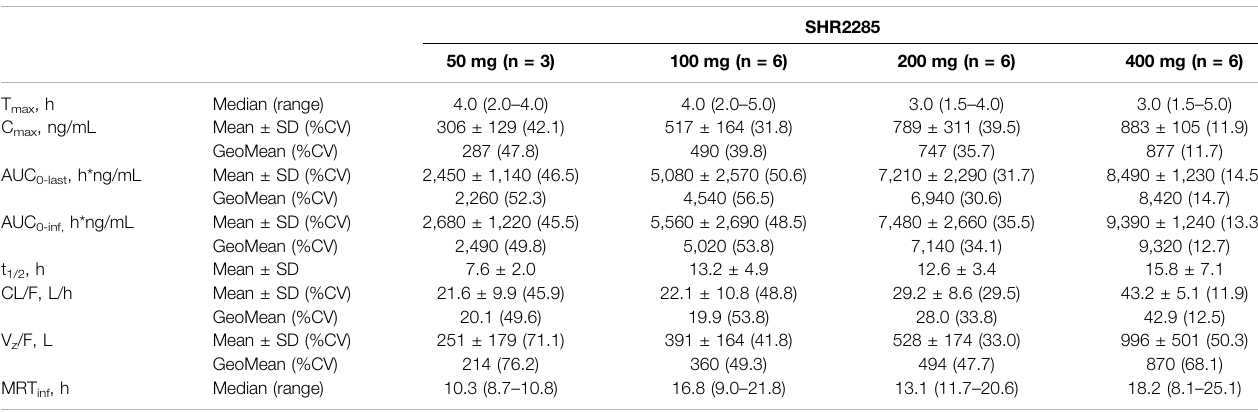
TABLE 3 | Pharmacokinetic parameters of